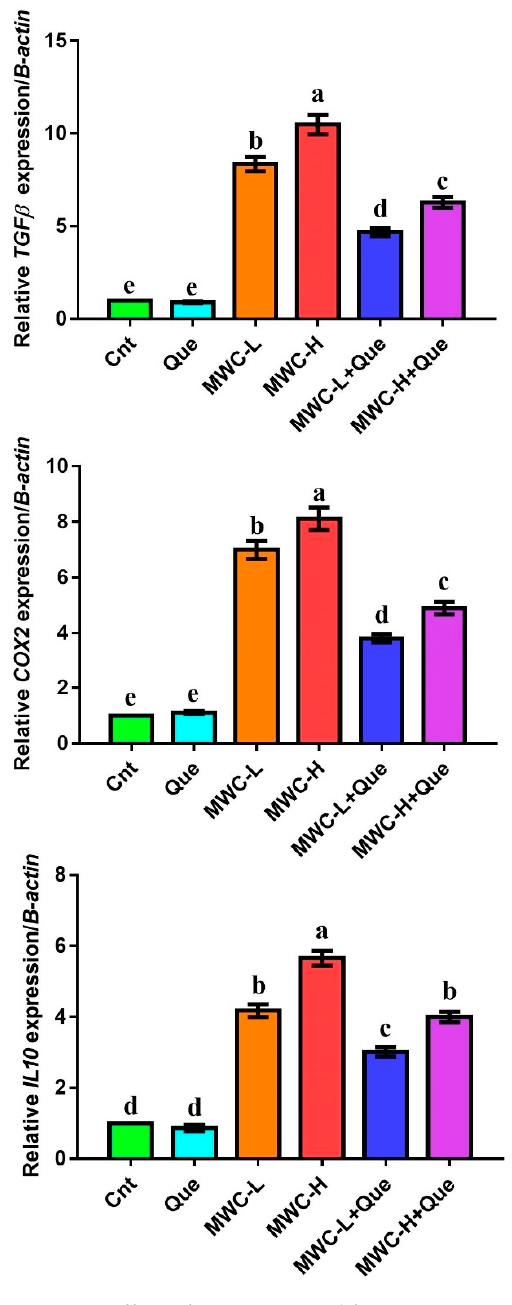
Figure 4. Effect of MWCNTs and/or quercetin on the relative expression of immunomodulatory genes (TGF β , COX2, IL10) as detected by qPCR. Data represent three independent experiments and were expressed as mean fold changes ± SEM (n = 5/group). Means within columns carrying different letters are significantly different at p ≤ 0.05. All groups were compared to each other. Cnt, control group; Que, quercetin-treated group; MWC-L, MWCNTs low dose-treated group; MWC-H, MWCNTs high dose-treated group; MWC-L+Que, MWCNTs low-dose and quercetin co-treated group; MWC-H+Que, MWCNTs high-dose and quercetin co-treated